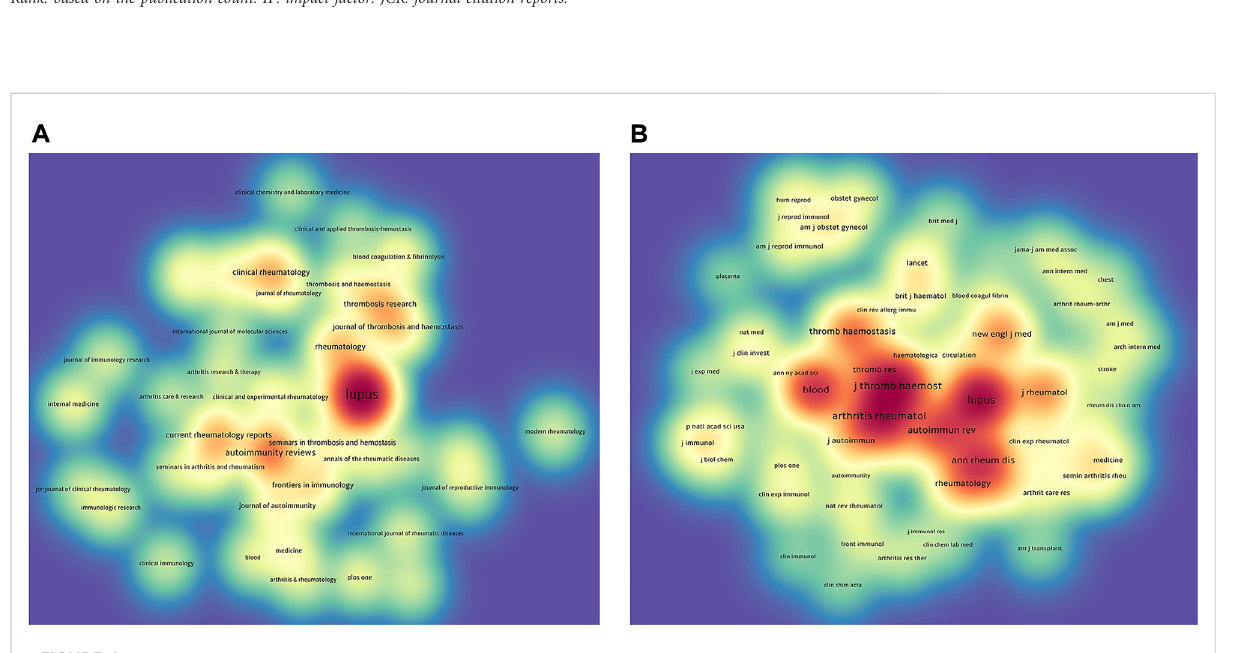
FIGURE 4 (A) VOSviewer density map of journals with publications ≥ 7 in APS research. The size of the title of the journal is proportional to the publication output. The more publications the journal produces, the closer the bottom background color is to red. (B) VOSviewer density map of co-cited journals with citations ≥ 120 involved in APS. The size of the title of the journal is proportional to the citation count. The more citations a journal receives, the closer the bottom background color is to